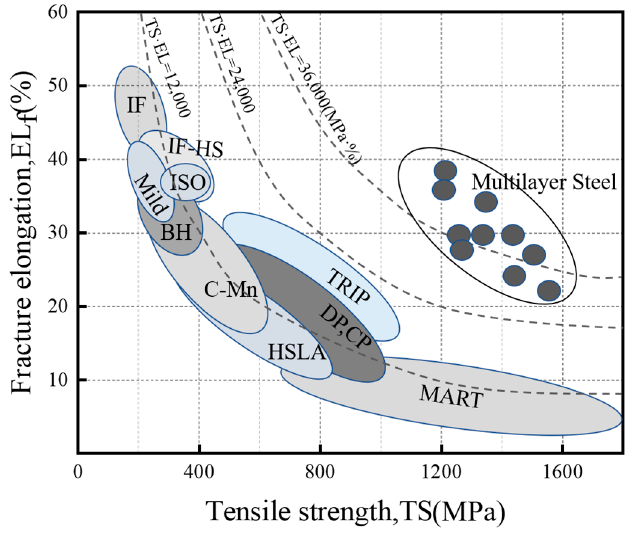
Figure 1. Strength-plastic relationships of monolithic metal materials and multilayer